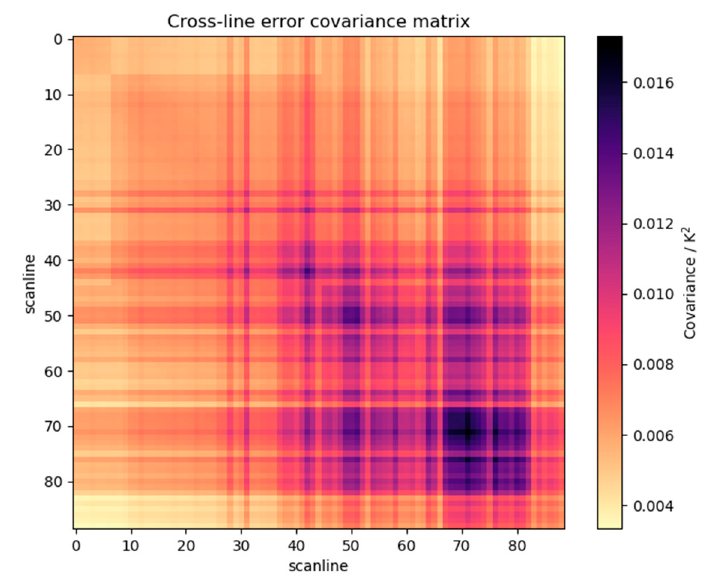
Figure 3. Cross-line error covariance matrix calculated for the line of constant element number through point ‘A’ of Figure 1. Since this is a descending pass of the satellite, the scanline indices 0 to 88 run from north to south (top to bottom) in Figure 1. The range of the colour scale corresponds to brightness temperature uncertainty from 0.06 K to 0.13 K. The matrix shown gives the error covariance from structured effects.